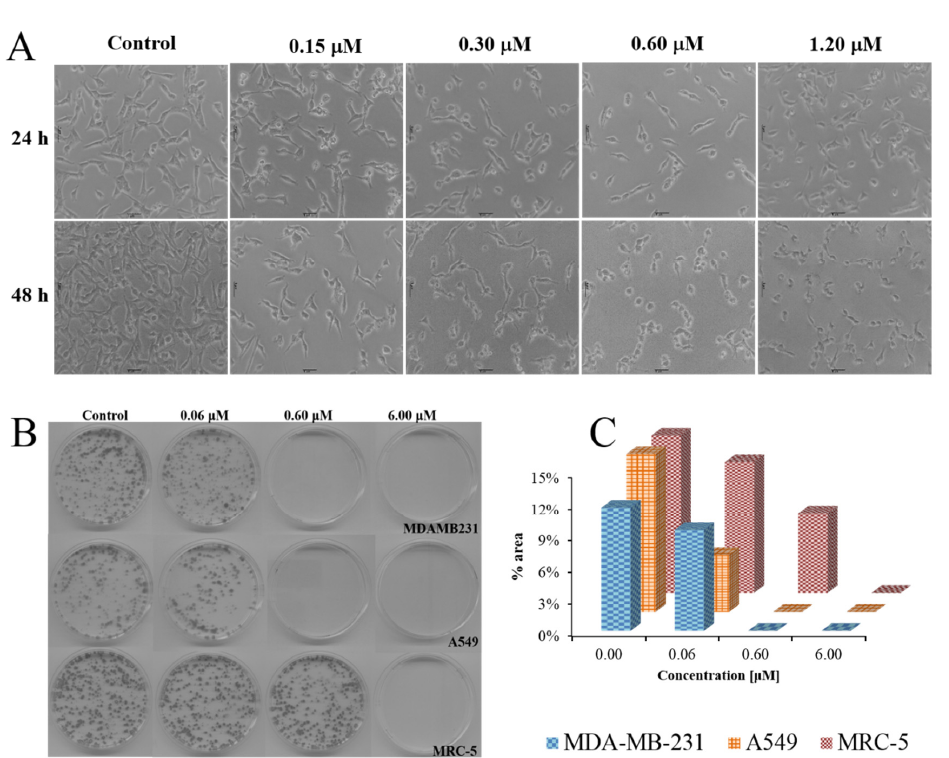
Figure 2. ( A ) Cellular Morphology of MDA-MB-231 treated with complex 3 . ( B ) Effects of complex 3 on MDA-MB-231, A549 and MRC-5 colony formation. Clonogenic assay of untreated cells (control) or treated with complex 3 . ( C ) Graph of colony area quantification.